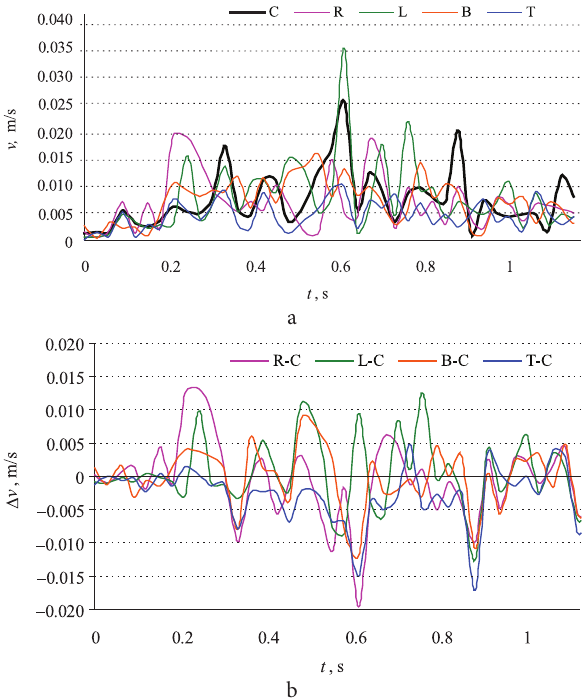
Fig. 13. Time histories of the absolute (a) and relative (b) displacements of the selected